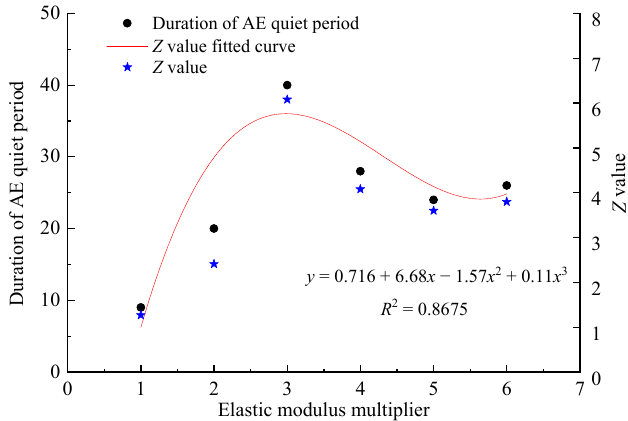
Figure 12. Z values of different elastic modulus specimens.